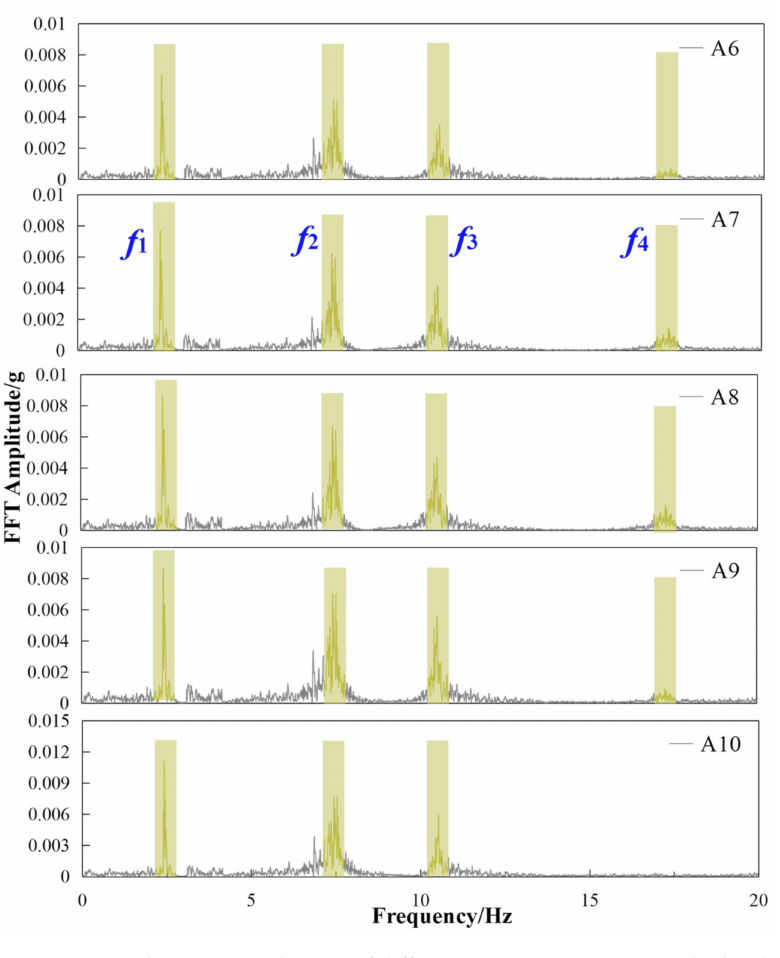
Figure 14. Acceleration time history of different measuring points inside the slope.